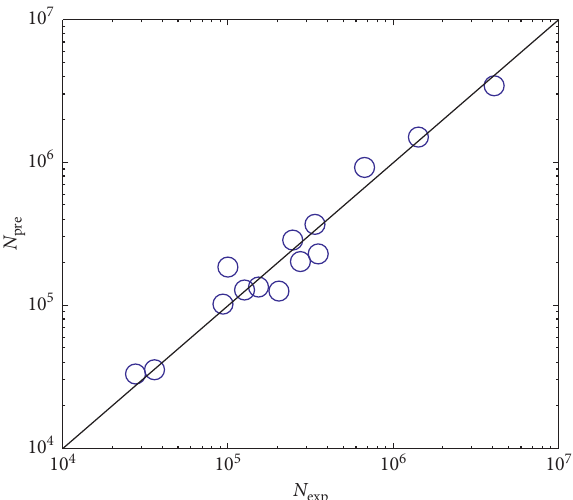
Figure 9: The experimental fatigue lives and model predictions.